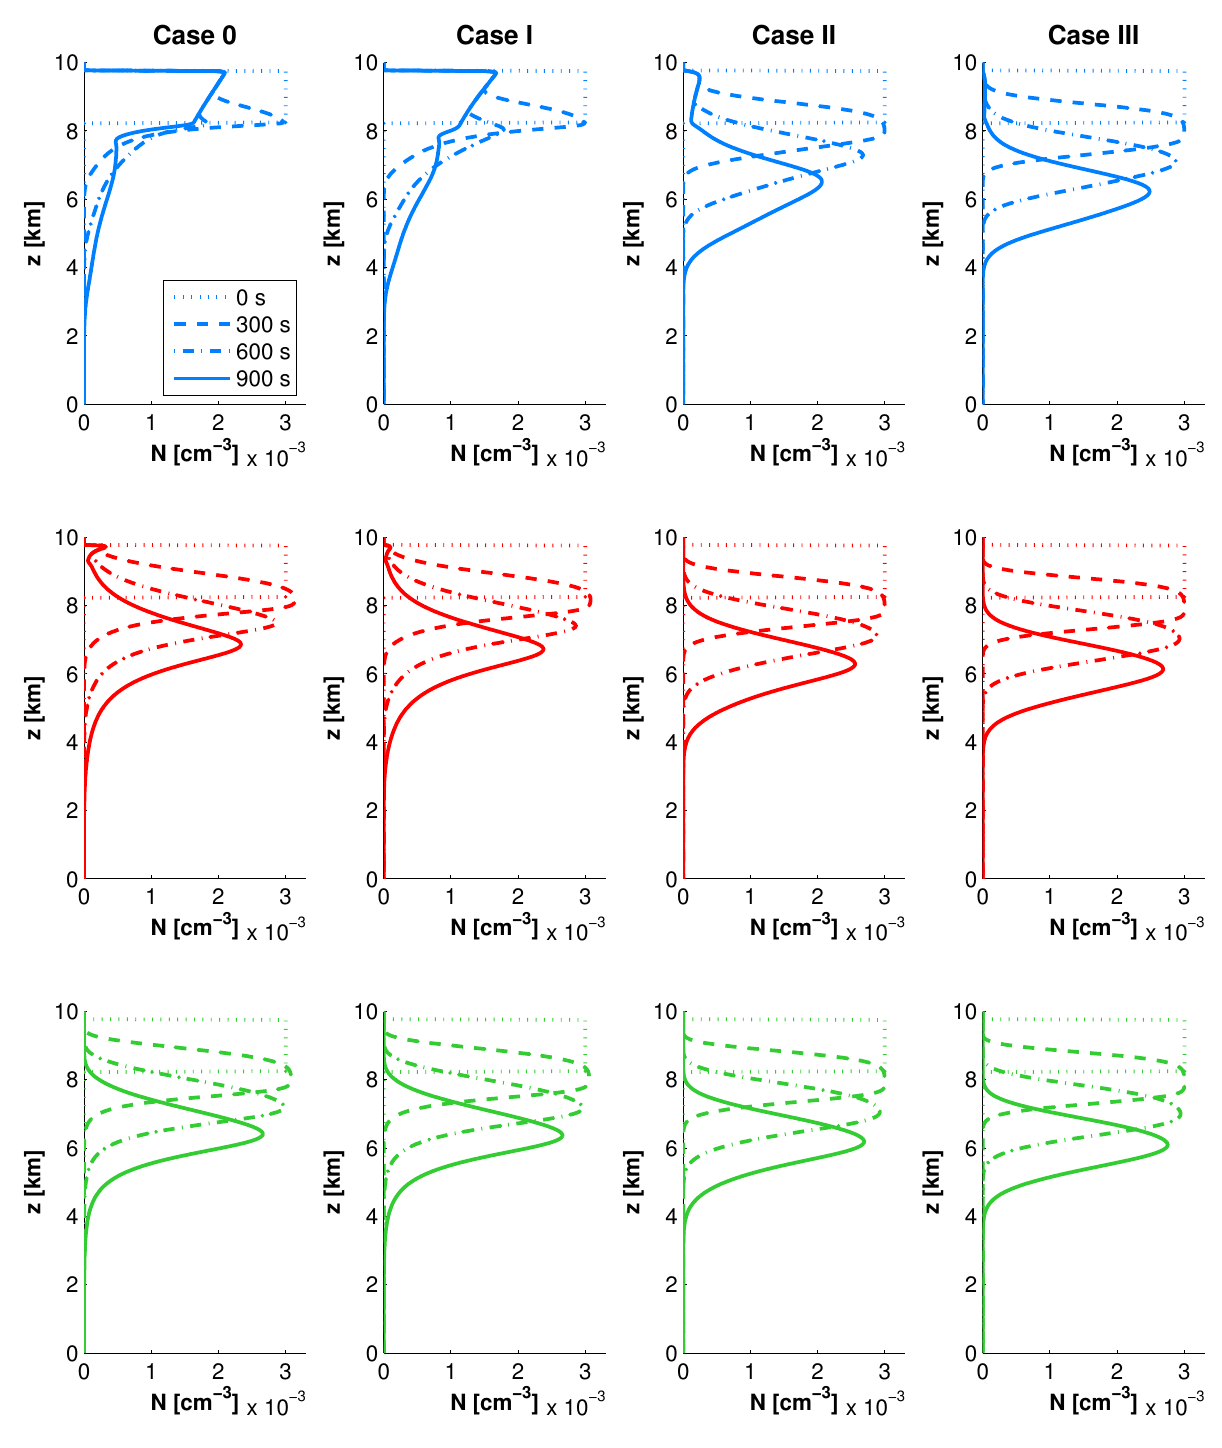
Figure 8. Evolution of number density profiles in the BOX case for four different initial conditions (see Table 5). Results presented in time steps of 300 s (legend as in Figure